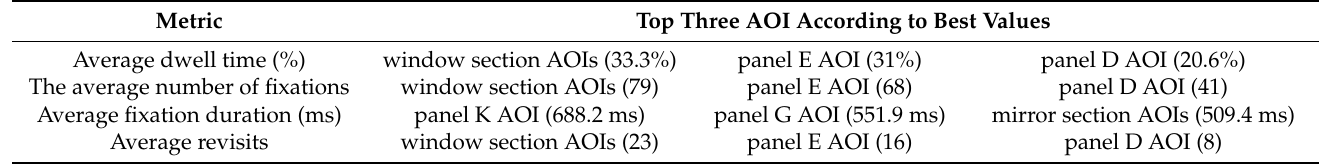
Table 3. The departure procedure’s average statistic for railway stop Horn ý Hriˇcov. Top Three AOI According to Best